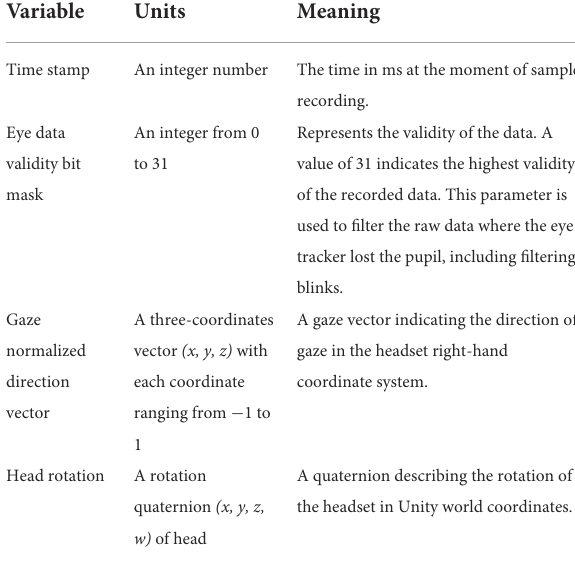
TABLE 1 Main eye- and head-movement-related raw variables recorded during the